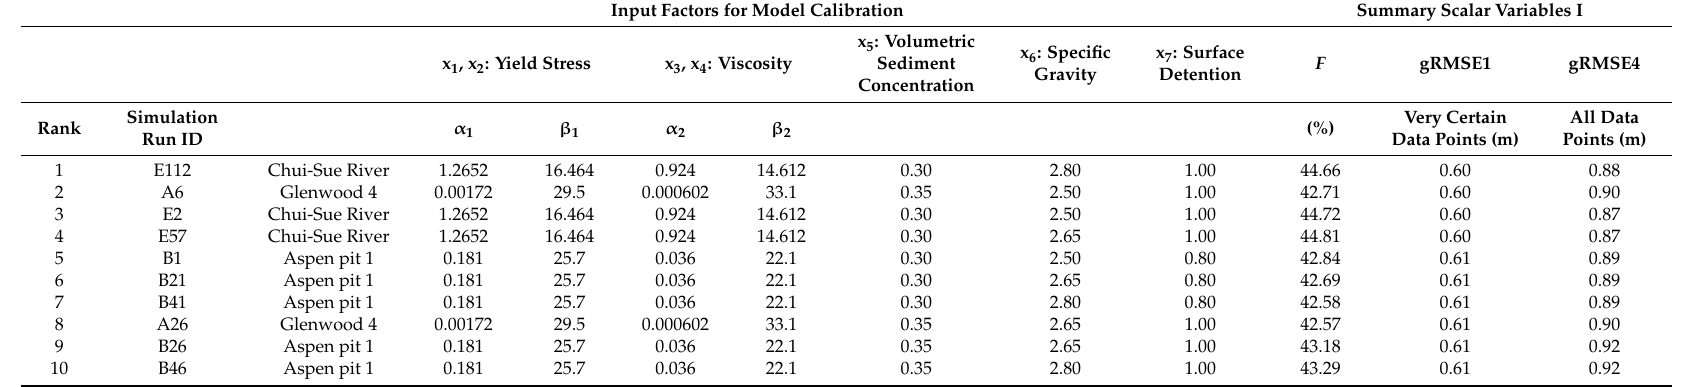
Table 5. Overview of the top 10 performing simulations based on lowest gRMSE1 values calculated with very certain reference height data